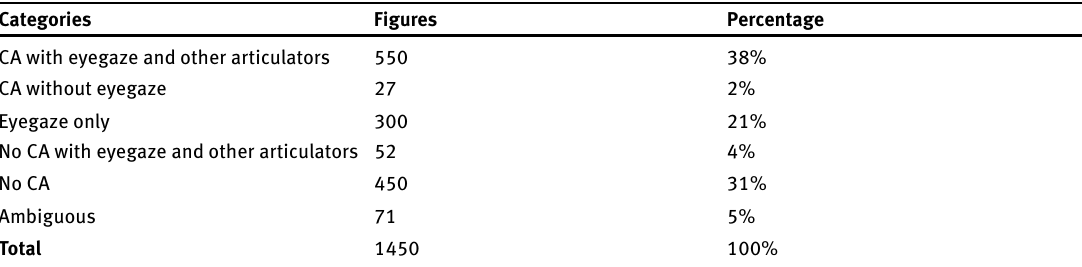
Table 3. Total set of constructed action/eyegaze categories coded